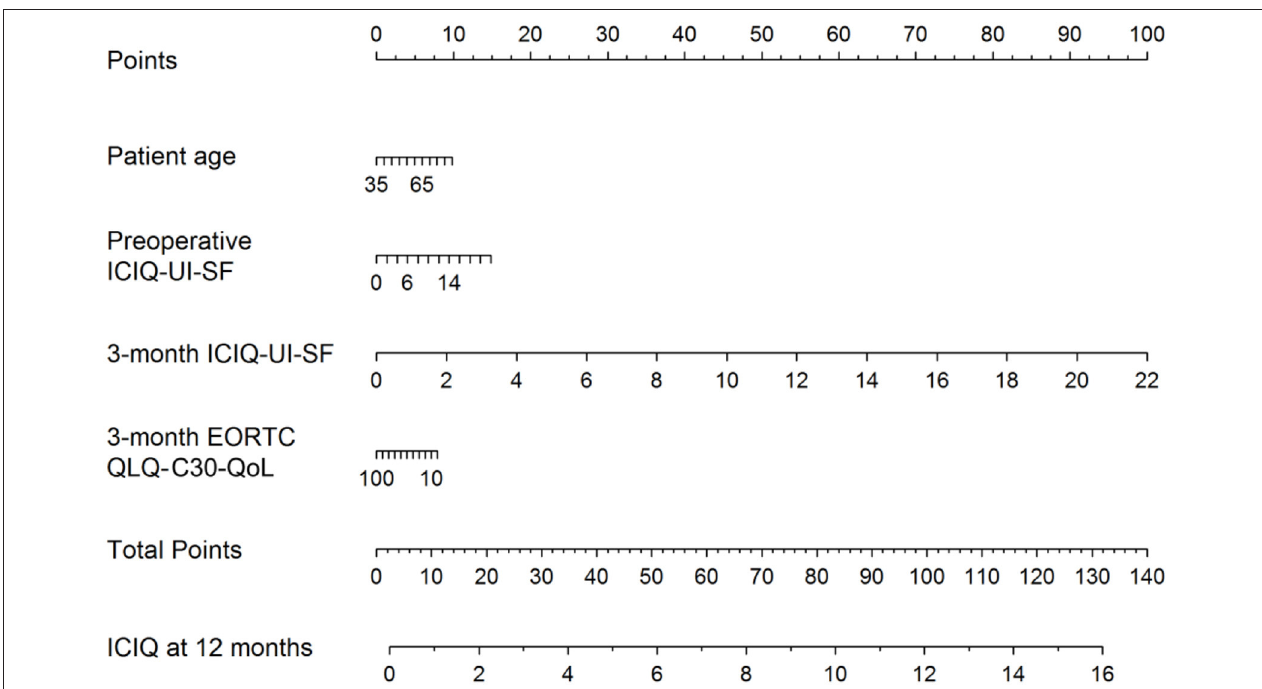
FIGURE 2 | Nomogram for the postoperative prediction of the 12-month ICIQ-UI-SF score among patients diagnosed with prostate cancer and treated with robotic-assisted laparoscopic prostatectomy. Instructions: locate the patient’s values for age, 3-month EORCT QLQ-C30/QoL, intraoperative complications, preoperative ICIQ-UI-SF and 3-month ICIQ-UI-SF on the corresponding axes. Draw a straight line up to the Points axis for each value to determine the number of points for that value. Calculate the sum of the values on the Points axis and locate this sum score on the Total Points axis. Draw a straight line down to find the patient’s predicted ICIQ-UI-SF score at 12 months. Taken From Tutolo et al. ( 44). EORCT QLQ-C30/QoL, European Organization for Research and Treatment for Cancer Quality of Life Questionnaire of Prostate Cancer; ICIQ-UI-SF, International Consultation on Incontinence Questionnaire-Urinary Incontinence Short